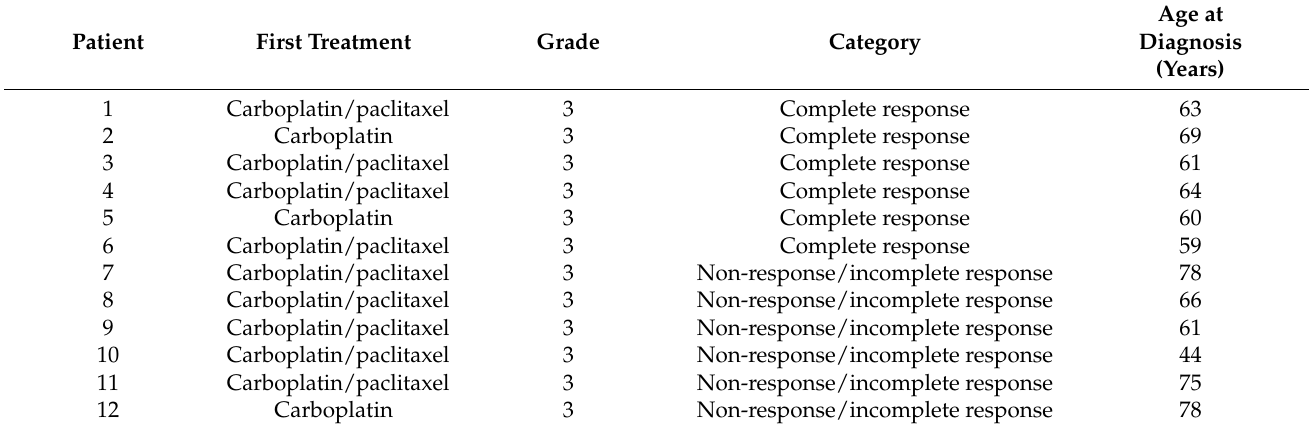
Table 1. Clinicopathological information for the HGSOC patients used in the